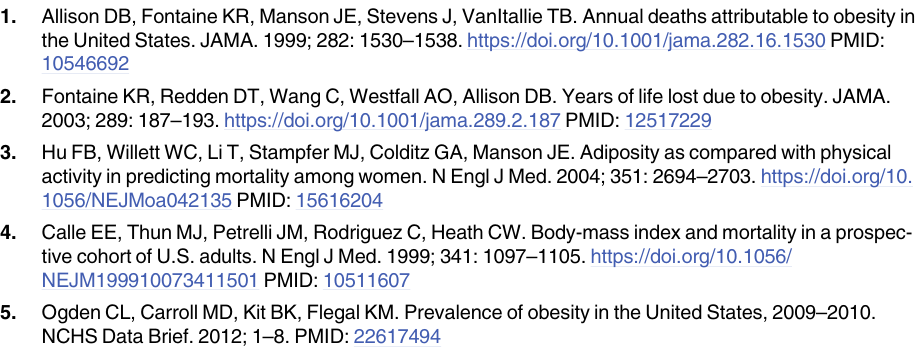
S4 Table. GSEA HOMA-IR PC heterogeneity taxonomy subclass results. Includes all Het- erogeneity Metabolite Set Analysis of full model meta-analysis results for the 22 metabolite sets. Same columns as S3 Table. S1 Fig. HOMA-IR PC logMetabolite analysis—Univariate model—Triradylcglycerols— Carbon downsloping plot—Sig. Plot of TAG metabolite effect size from random effects meta- analysis of univariate model vs number of carbon atom in the TAG. S2 Fig. HOMA-IR PC logMetabolite analysis—Univariate model—Triradylcglycerols— Bond downsloping plot—Sig. Plot of TAG metabolite effect size from random effects meta- analysis of univariate model vs number of double bonds in the